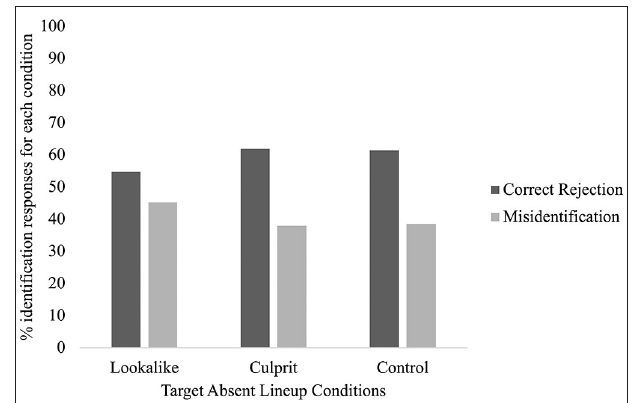
FIGURE 1 | The proportion of identification responses (correct identifications, misidentifications, and incorrect rejections) for the TP lineup conditions (culprit, lookalike, and control).